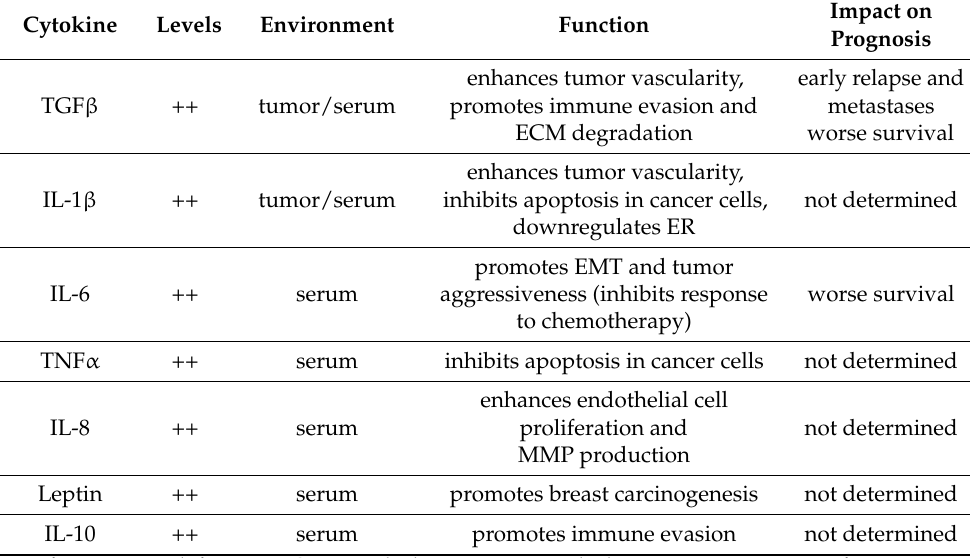
Table 2. Cytokine levels and breast cancer